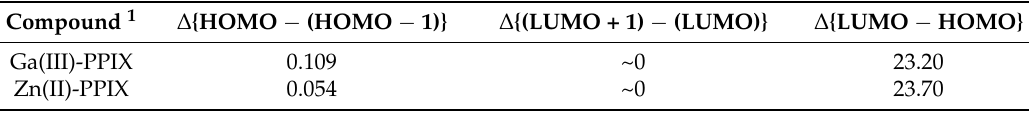
Table 1. HOMO/LUMO energy gaps in Ga(III) and Zn(II)-PPIX complexes. Values are in kcal·mol − 1 . Compound 1